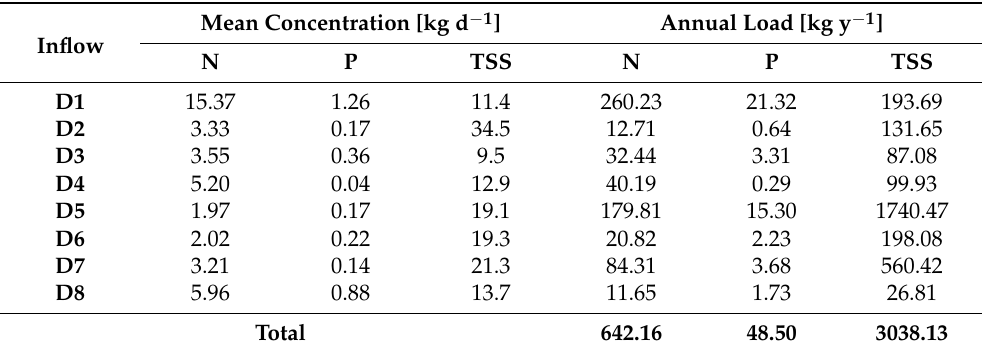
Table 4. Annual nitrogen (N), phosphorus (P), and total suspended solids (TSS) loads discharged to the lake, calculated on analyzed concentrations, catchment area and multiannual average unit outflow. Inflow